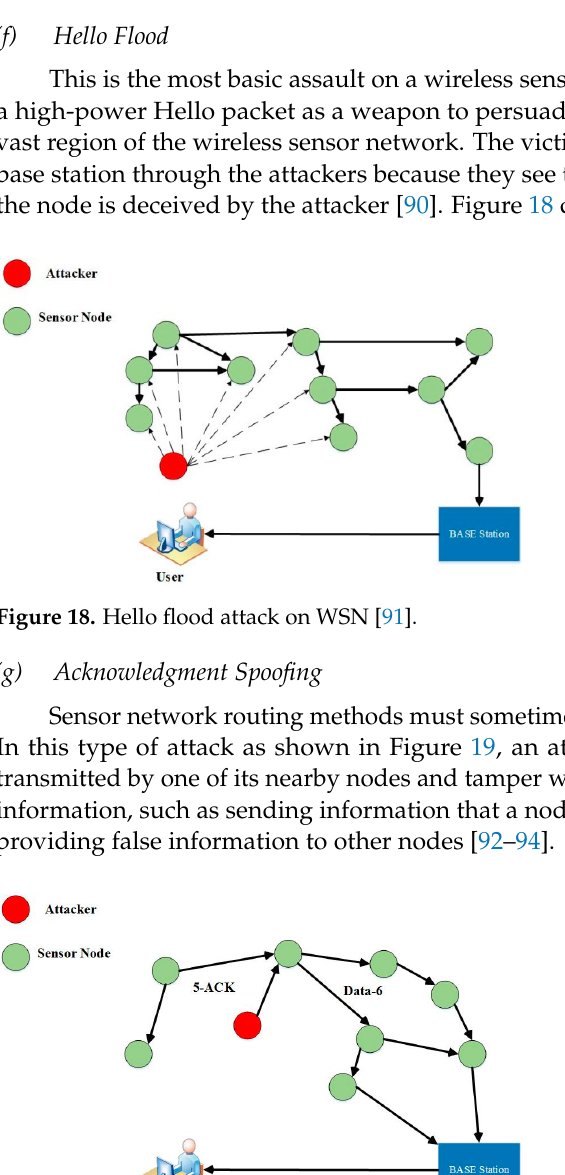
Figure 17. Wormhole attack on WSN [88,89].